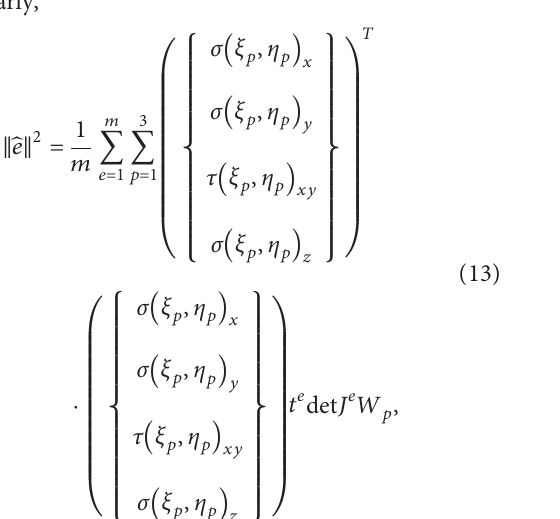
Figure 3: Specimen with a hole at its center and three interacting cracks (all dimensions are in